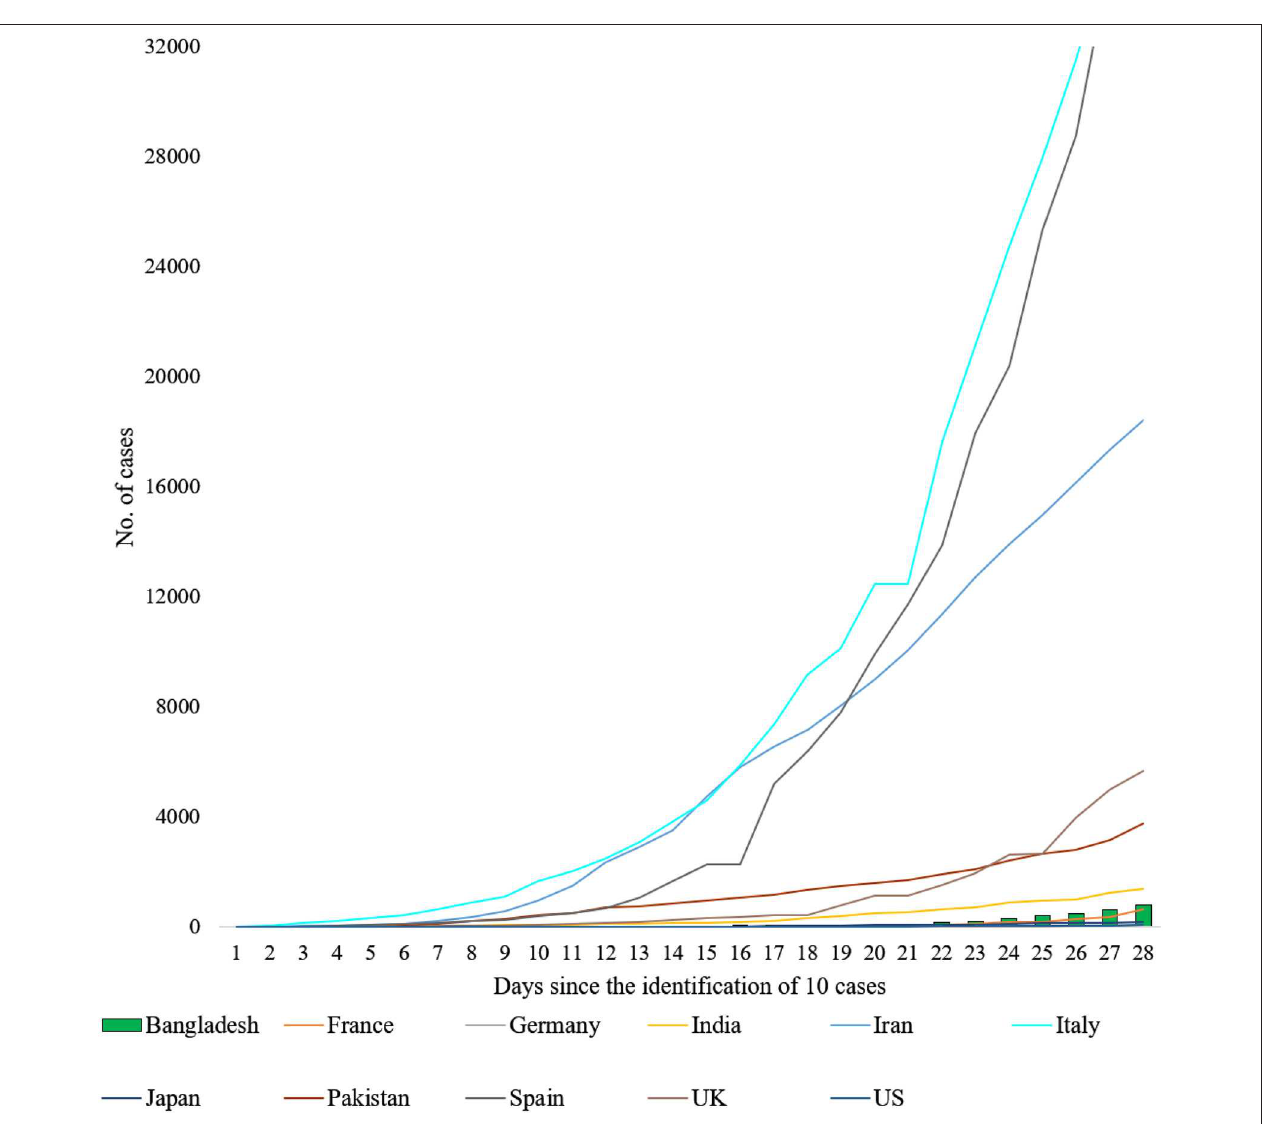
FIGURE 3 | Total number of COVID-19 cases daily after the identification of the 10th case in Bangladesh and in 10 other countries (1, 7). Bangladesh’s trendline is comparable with the trendlines of France and Japan. As of now (April 13, 2020), the trendline of the US remains far lower (74 total cases on day 28) than Bangladesh’s until the 28th day after the identification of 10 positive